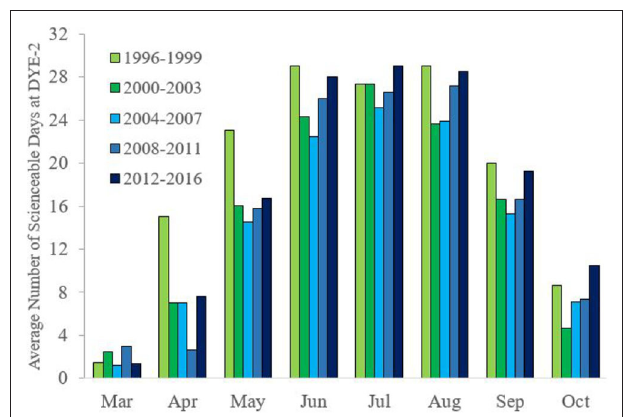
FIGURE 5 | Mean number of scienceable days per month at DYE-2 calculated for five 4 year time periods between 1996 and 2016. Days with missing wind or temperature data were excluded from both plots resulting in data being available for 87% of days used for each day of the year of the left plot and 83% of days for the columns of the right